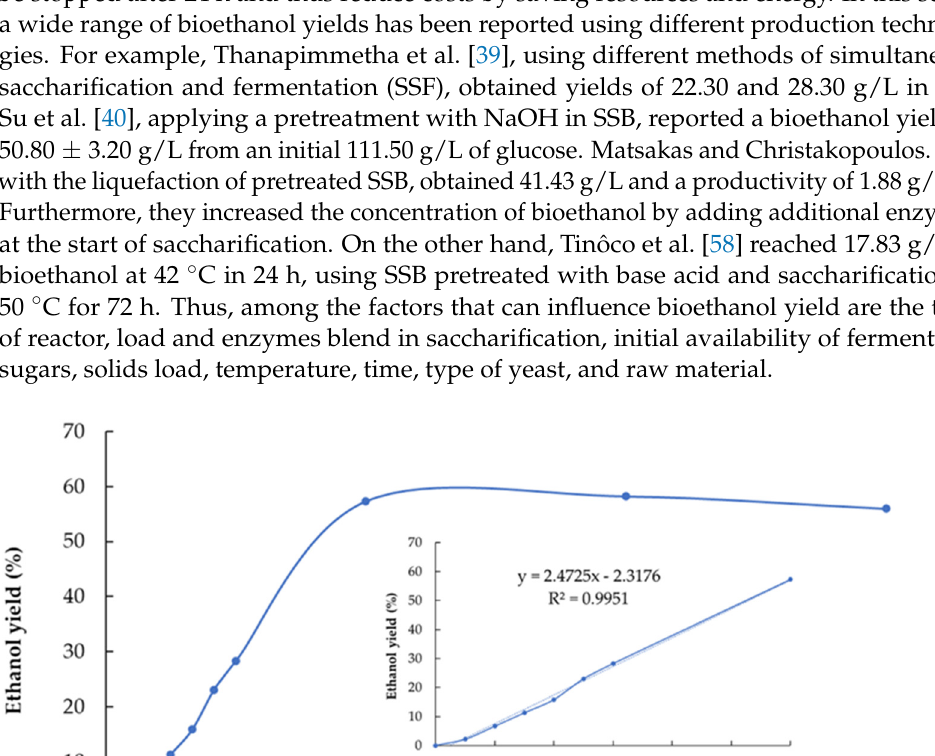
Figure 6. Bioethanol yield.